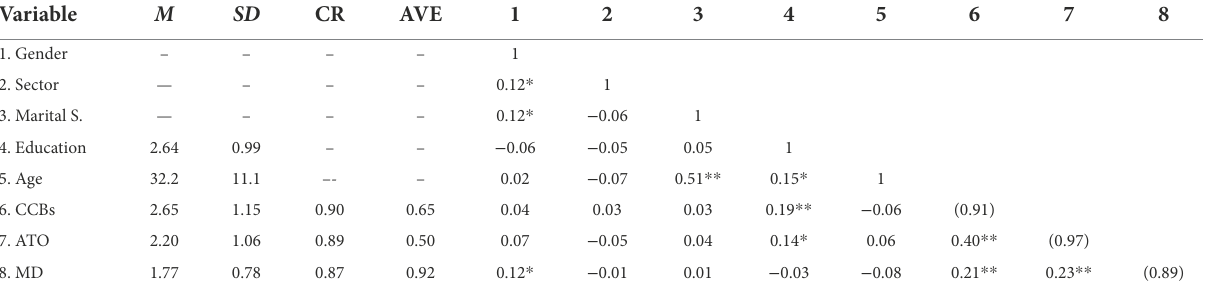
TABLE 2 Means, standard deviations, and correlations with confidence intervals ( n = 294).